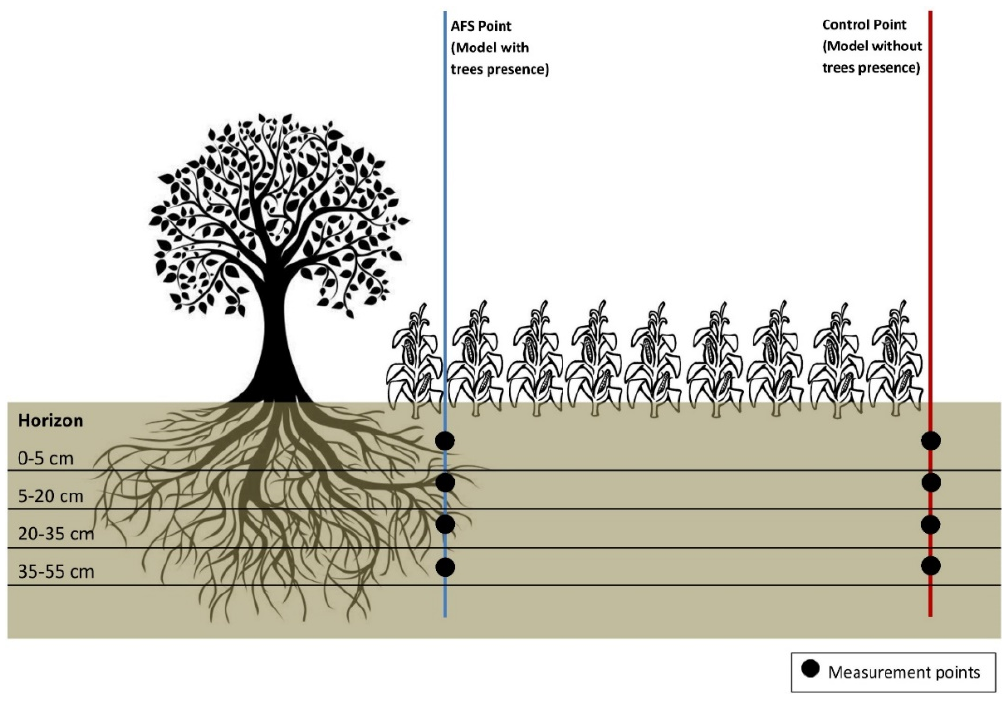
Figure 1. Schematic representation of the modeled field and the comparison rationale.